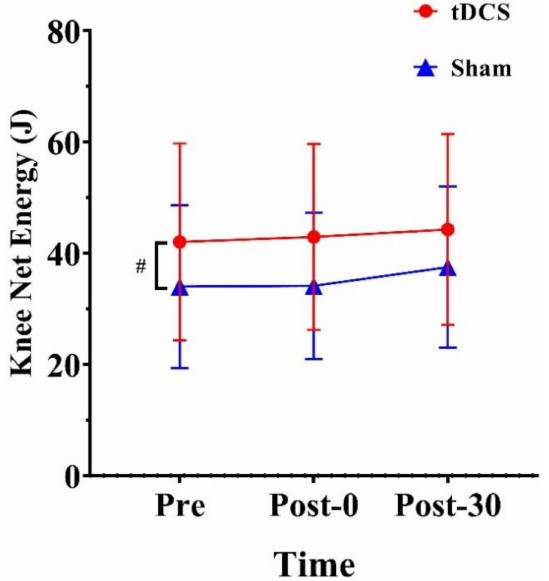
Figure 6. Effects of tDCS on knee net energy in CMJs. # indicates a significant main effect of condition. Pre: pre-stimulation, Post-0: post-0 min, Post-30: post-30